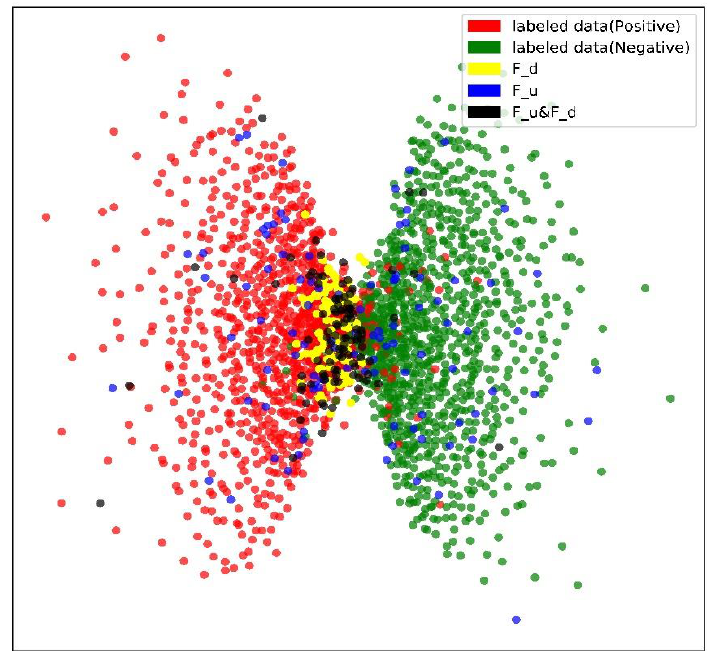
Figure 3. MDS visualization of three different strategies. Red points represent negative labeled data, and green points represent positive labeled data. The boundary between the two classes is basically clear. Blue points ( F u ) represent samples selected based on uncertainty strategy in an iteration, yellow points ( F d ) are samples selected based on diversity strategy (according to (12)), and black points ( 𝐹 𝑢 & 𝐹 𝑑 ) represent selected samples that combine uncertainty and diversity.